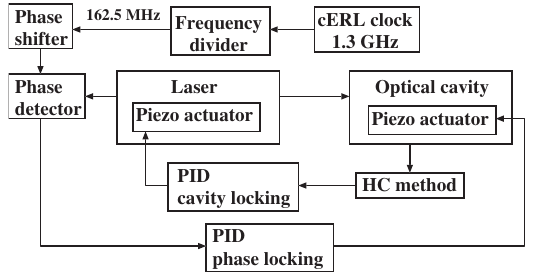
FIG. 14. Block diagram of the feedback